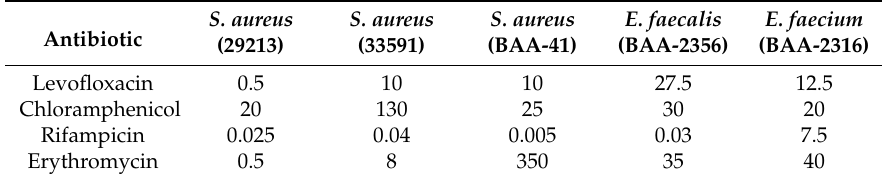
Table 3. Minimum inhibitory concentrations (MICs) of antibiotics against the tested bacterial strains. MIC values are displayed in ( µ M) concentration. Results represent